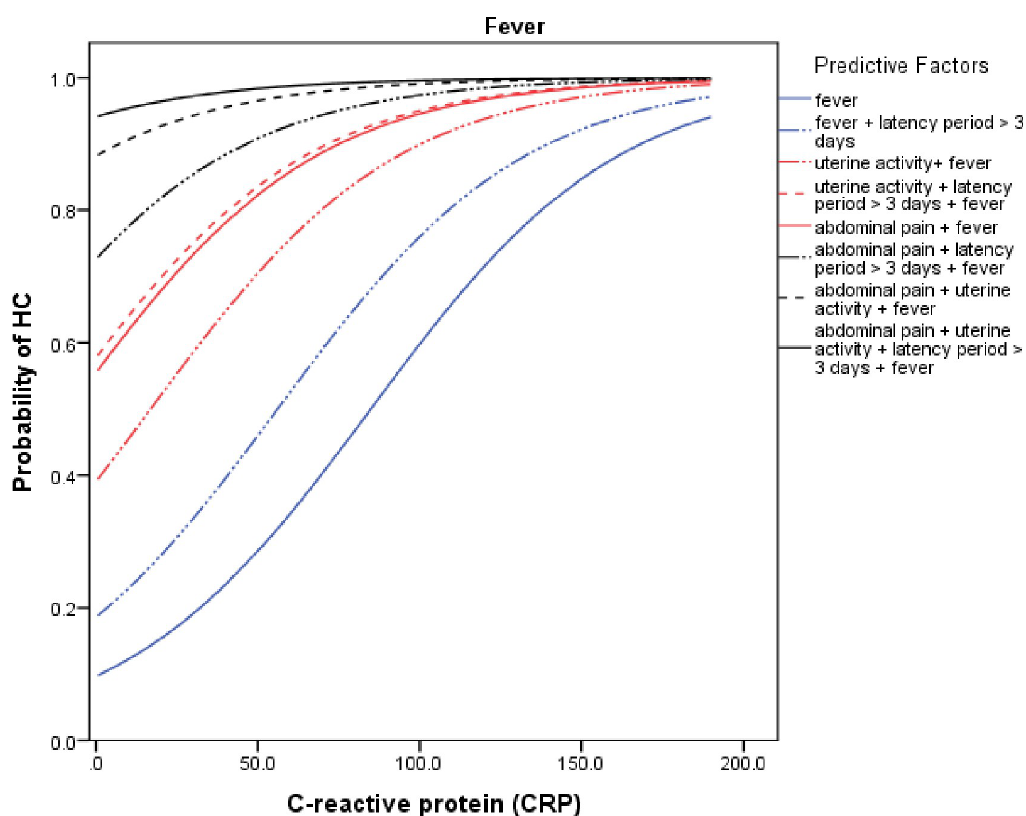
Fig 2. Probability curve of the HCA event according to CRP levels in the presence of various clinical conditions without maternal fever ( < 37.8 ˚C).